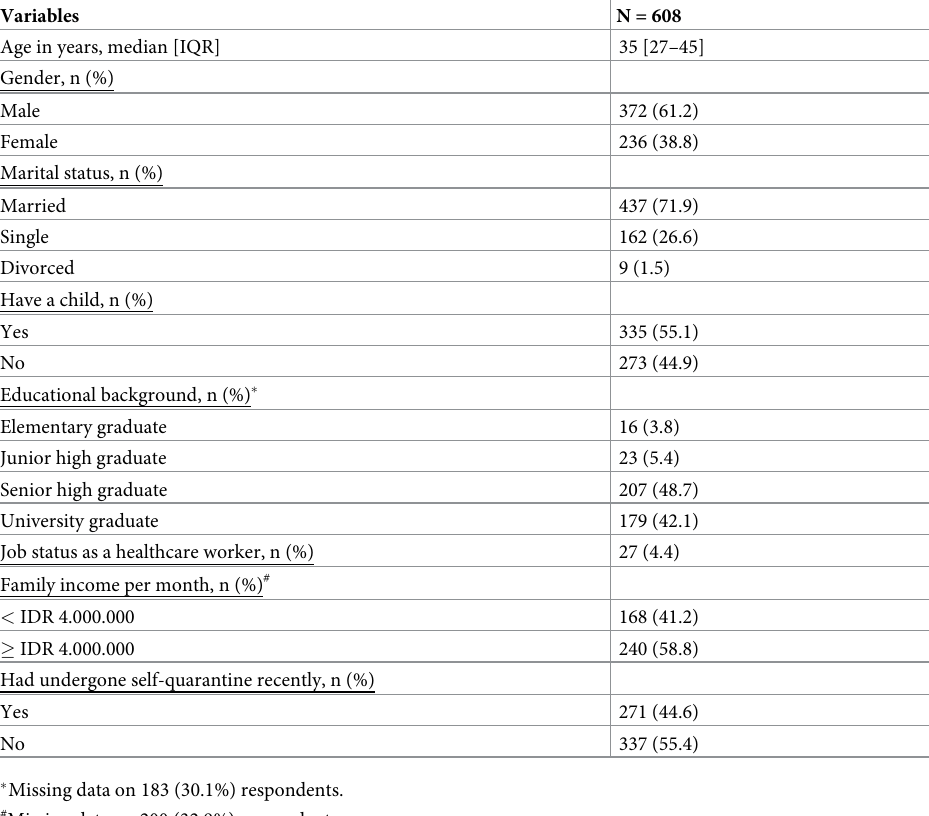
Table 2. Sociodemographic characteristic of the study participants. Variables